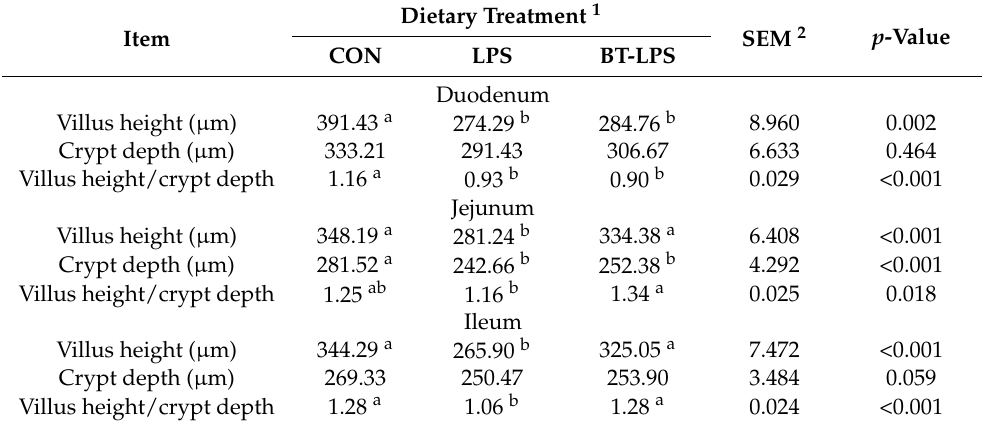
Table 2. The effects of butyrate on intestinal morphology in piglets challenged with LPS. Dietary Treatment Item